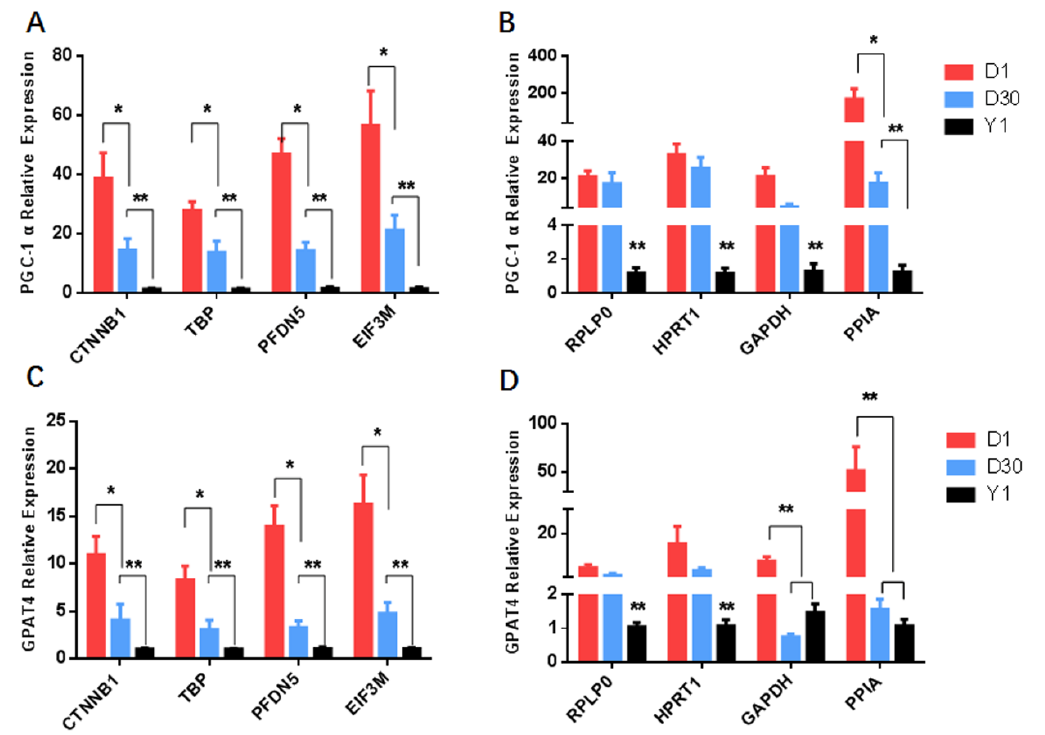
Figure 2. Relative expression of PGC1α and GPAT4 normalized to the different reference genes across three development stages (D1, D30, and YI). ( A ) Relative expression of PGC1α by the most stable genes ( CTNNB1 , TBP , PFDN5 , and EIF3M ). ( B ) Relative expression of PGC1 α by the least stable reference genes ( RPLP0 , HPRT1 , GAPDH , and PPIA ). ( C ) Relative expression of GPAT4 by the most stable genes ( CTNNB1 , TBP , PFDN5 , and EIF3M ). ( D ) Relative expression of GPAT4 by the least stable reference genes ( RPLP0 , HPRT1 , GAPDH , and PPIA ). * p < 0.05, ** p < 0.01.